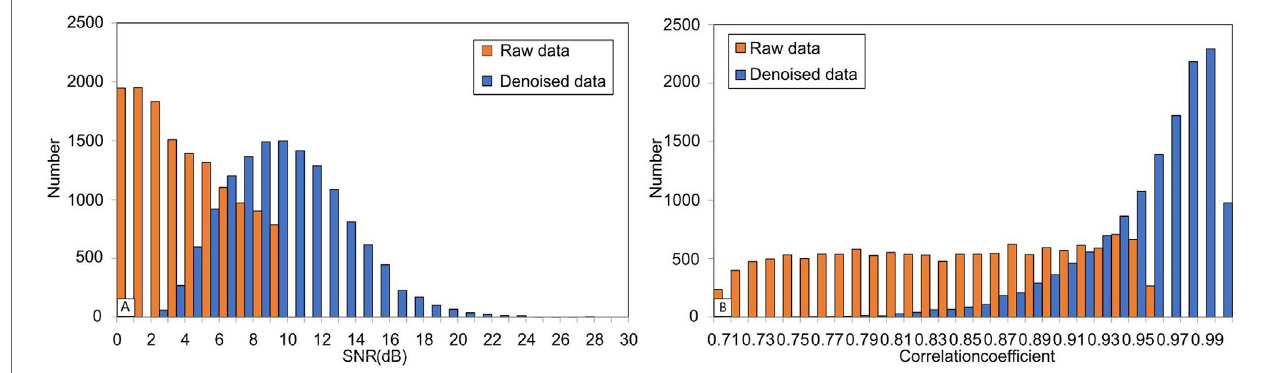
FIGURE 5 | Histogram of the SNR and correlation coef fi cient for the test dataset: (A) SNR improvement histogram; (B) correlation coef fi cient improvement histogram.